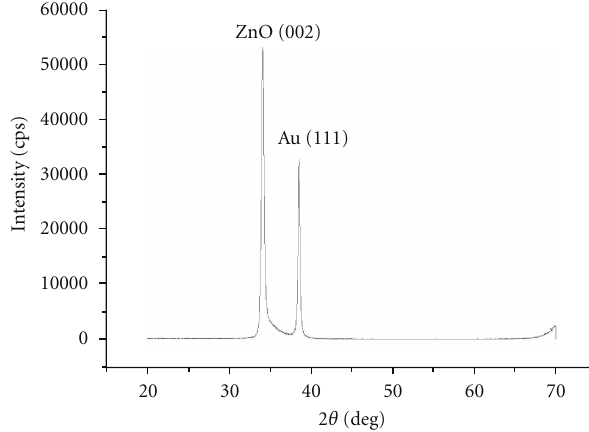
Figure 9: XRD pattern of the ZnO film on Au.